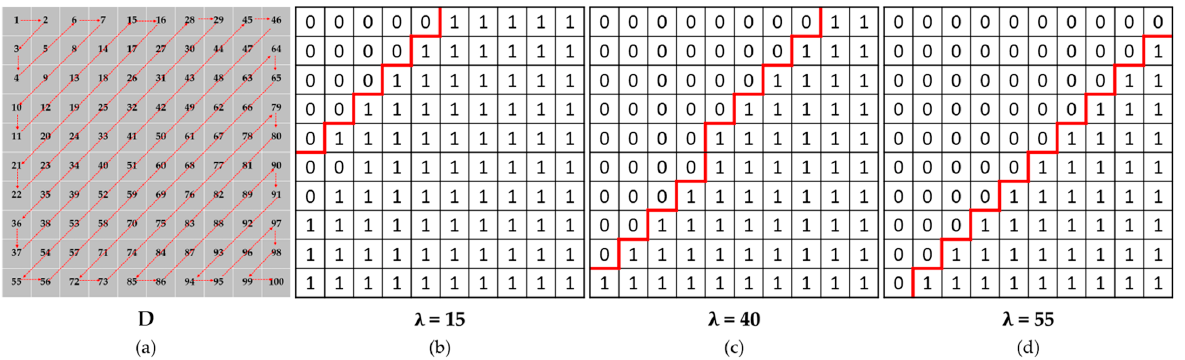
Figure 9. ( a ) Index of zig-zag scan for 10 × 10 pixels. ( b ) A mask obtained from the hyperparameter λ of 15. ( c ) A mask obtained from the hyperparameter λ of 40. ( d ) A mask obtained from the hyperparameter λ of 55.